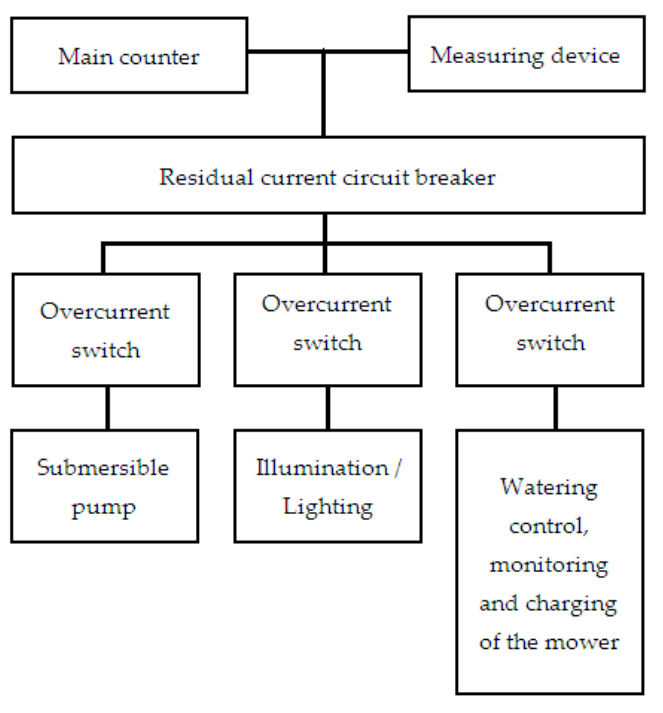
Figure 2. Schematic illustration of analyzed system for data collection.